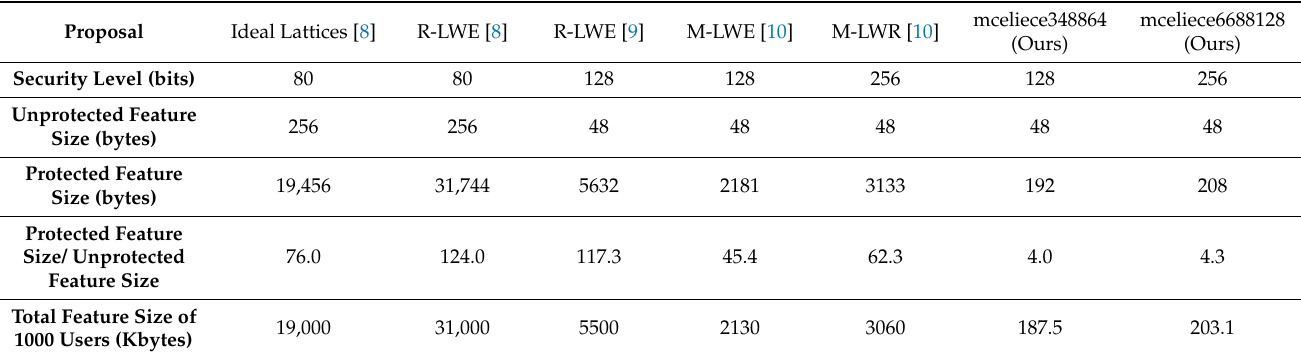
Table 2. Size performance comparison of post-quantum biometric protection proposals based on homomorphic